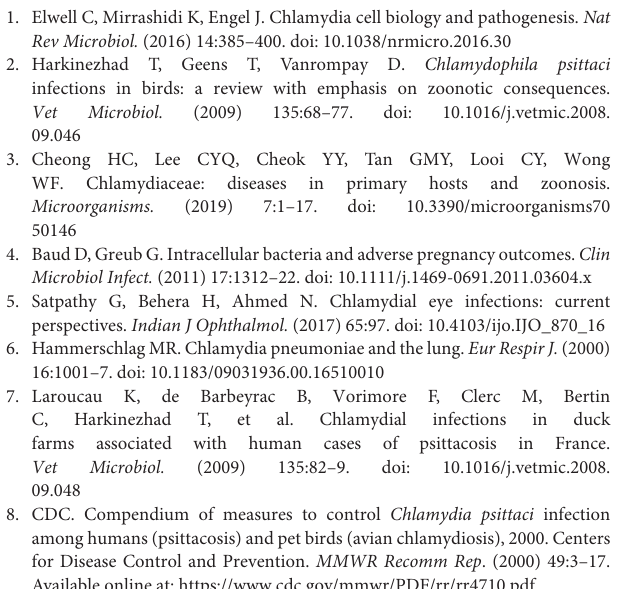
Supplementary Table 1 | Clinical scoring. Supplementary Table 2 | Scoring system to evaluate the pathology of deparaffinized lung